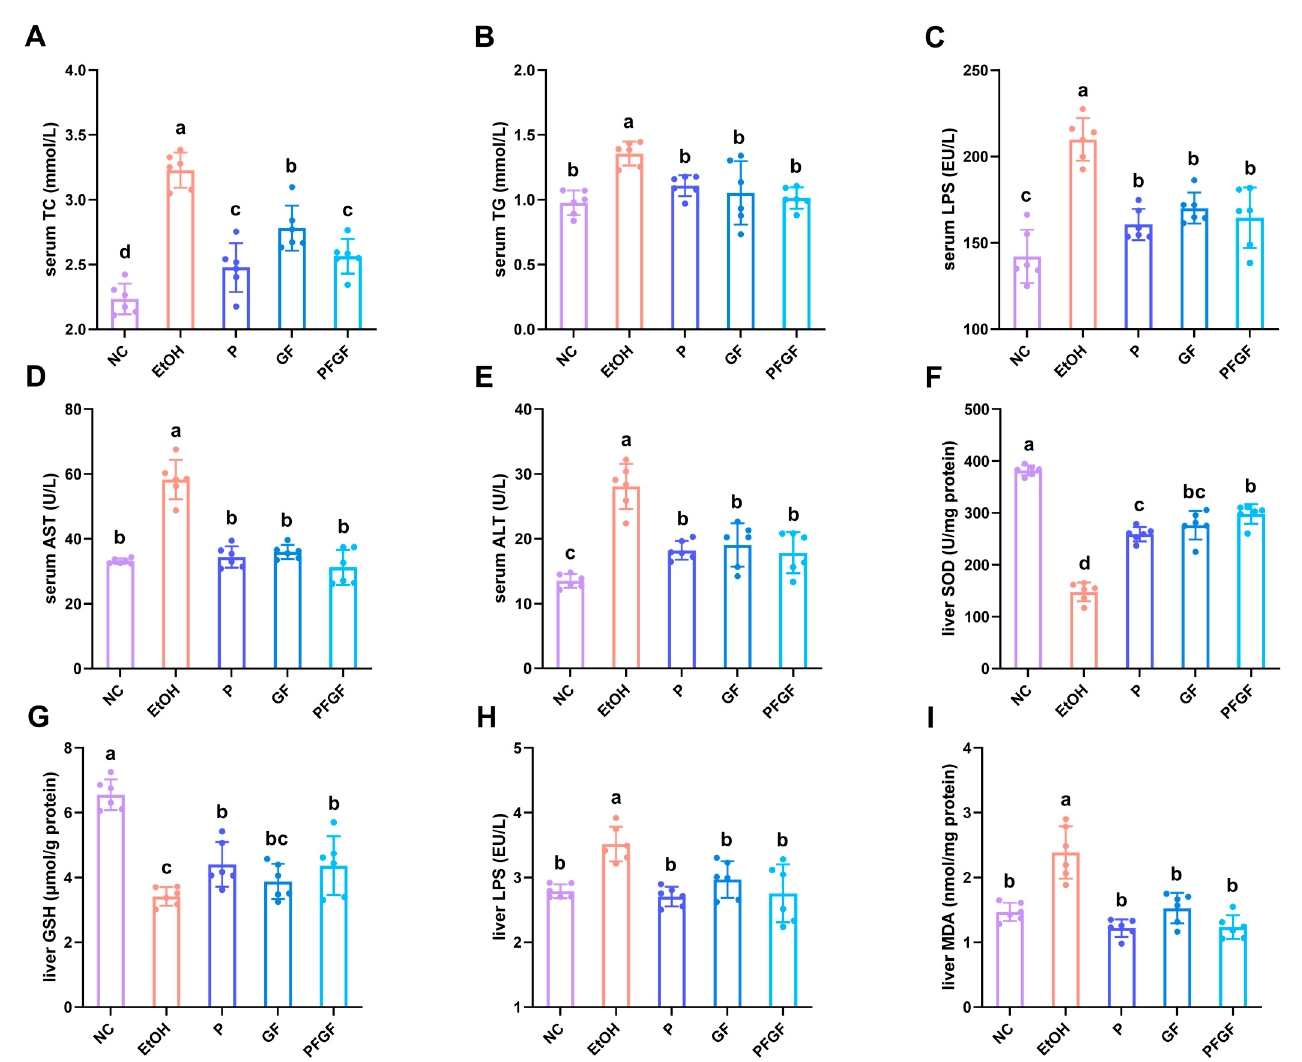
Figure 2. Effects of P, GF, and PFGF on serum TC ( A ), TG ( B ), LPS ( C ), AST ( D ), and ALT ( E ), and liver SOD ( F ), GSH ( G ), LPS ( H ), and MDA ( I ) in alcohol-fed mice. Data are expressed as mean ± SD ( n = 6). Different superscript letters indicate statistically significant differences between groups ( p < 0.05).